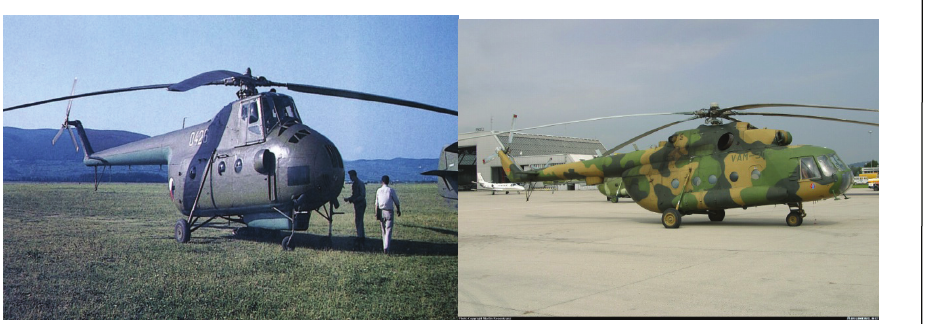
Figure 7 – Mi-4 (left) and Mi-8 (right) Рис . 7 – Ми -4 ( слева ) и Ми -8 ( справа ) Слика 7 – Ми -4 ( лево ) и Ми -8 ( десно